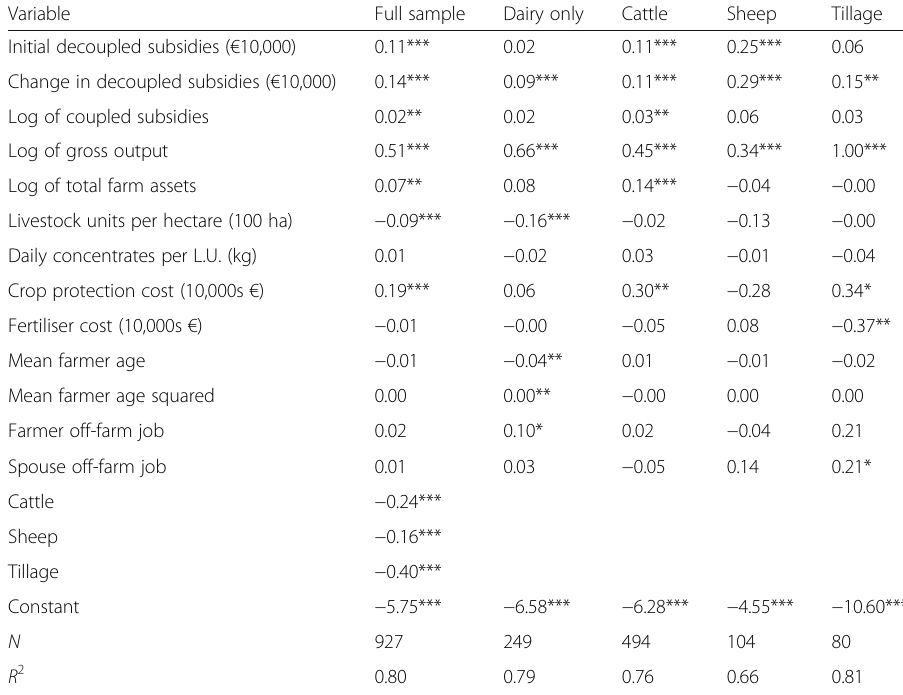
Table 3 Standard deviation of market income on Irish farms (farm wealth model) Variable Full sample Dairy only Cattle Sheep Tillage Initial decoupled subsidies ( € 10,000) Change in decoupled subsidies ( € 10,000)